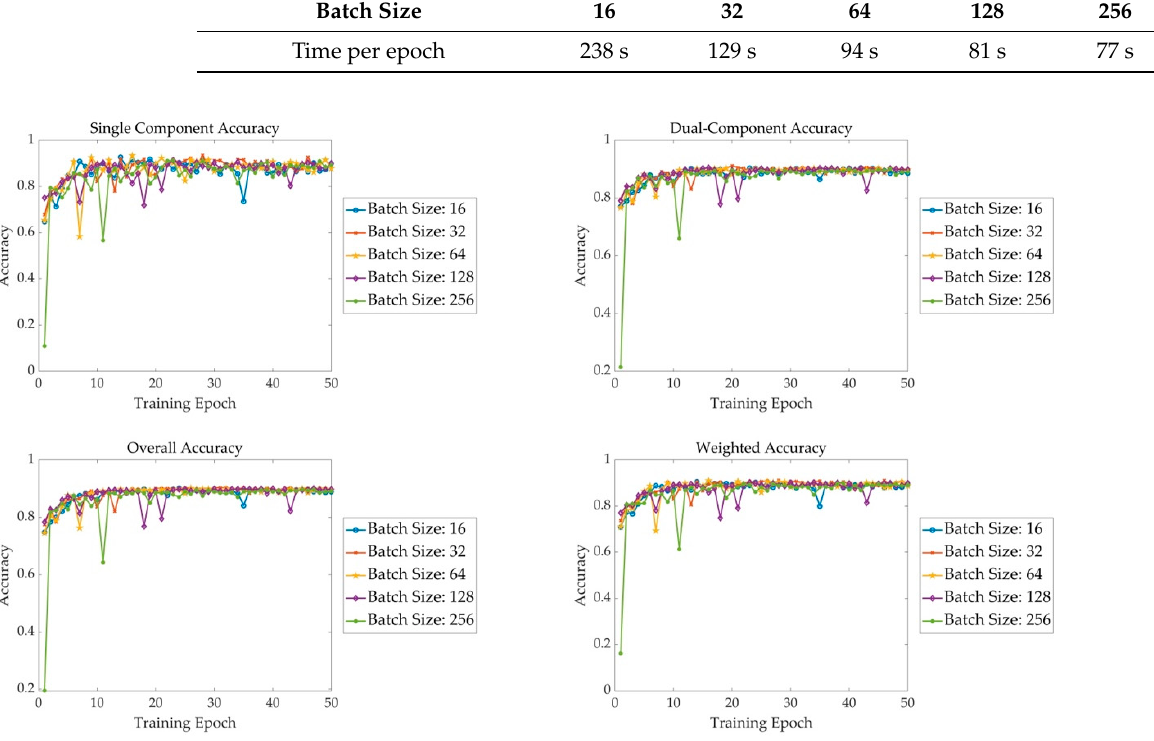
Figure A1. The accuracy of validation dataset at the end of each training epoch according to different batch size.